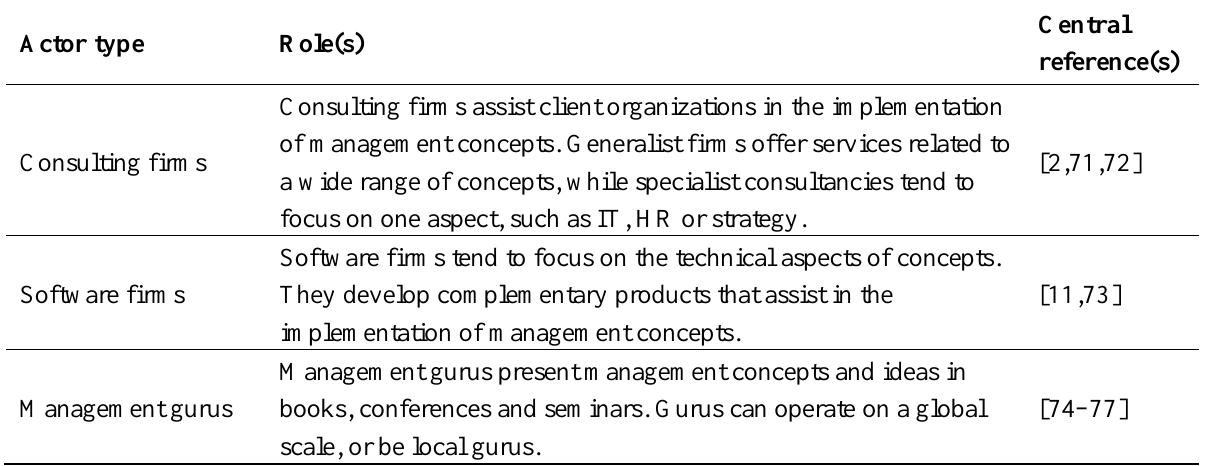
Table 1. The main actors involved in the management fashion